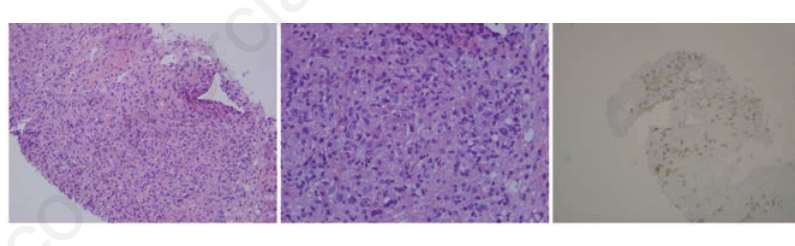
Figure 2. Extensive Lymphocytic, histiocytic infiltrates with abnormal large cells and pos- itive staining for CD 15 and CD 30 (From left to right).